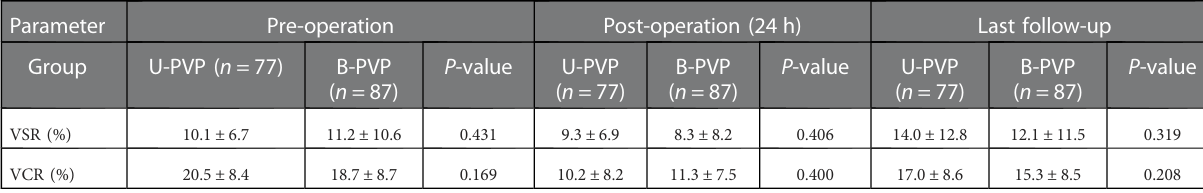
TABLE 5 The changes of vertebral sides ratio and vertebral compression ratio during follow-up period.